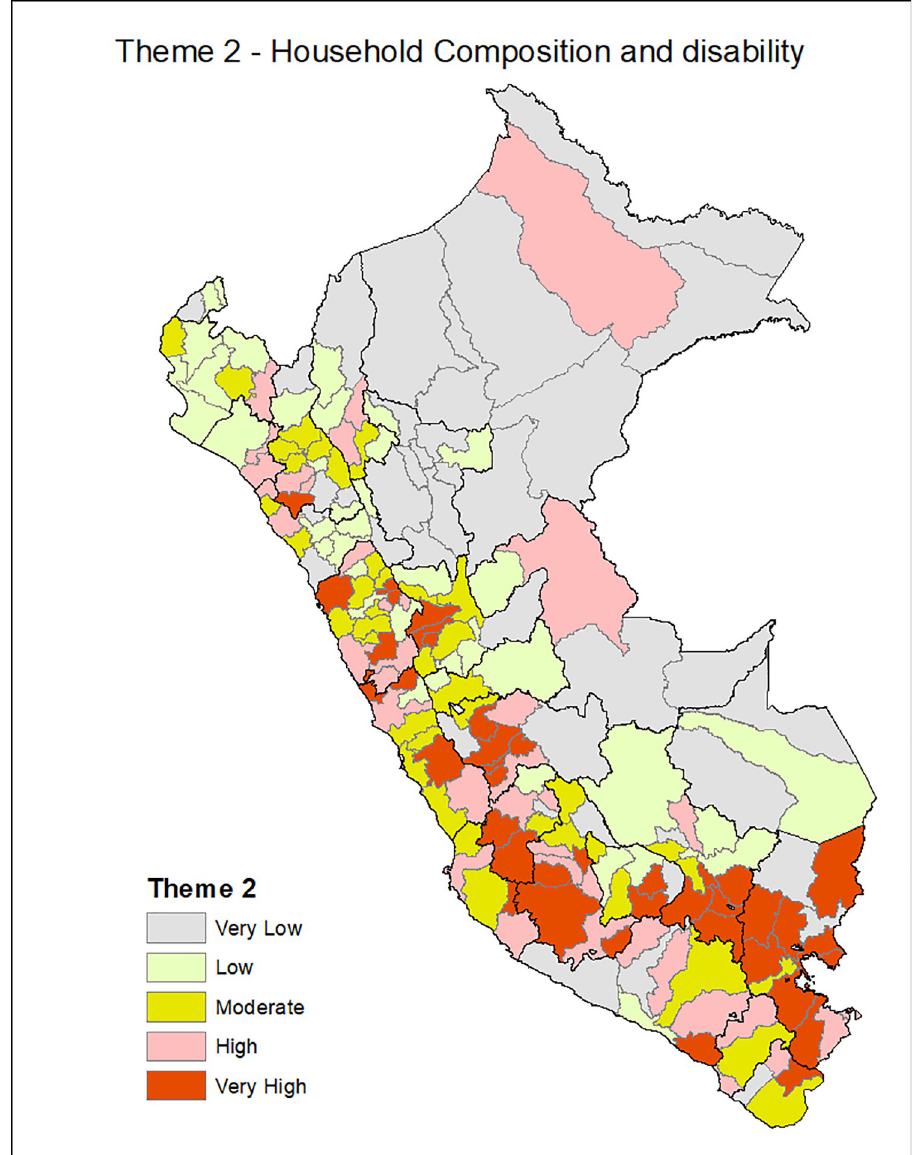
Fig 3. SVI topic 2: Household composition and